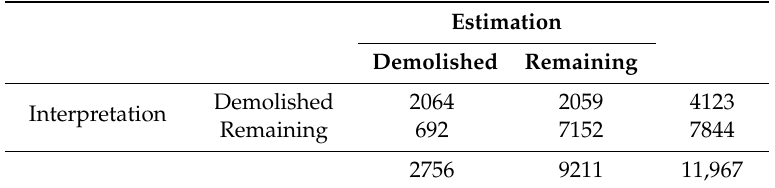
Table 12. Relationship between the building area >60 m 2 of the footprint and true false of the estimation by the indicator of 0.3 in the 25 March 2018 image.